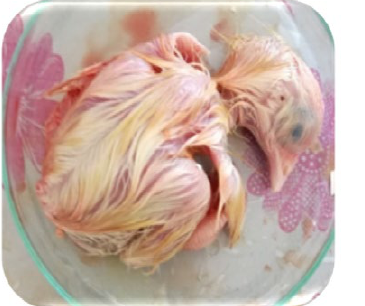
Fig. 8. large yolk sac which not absorbed by Fig. 7. Control group the chick Fig.7. large yolk sac which not absorbed by the chick Fig.6. Control group